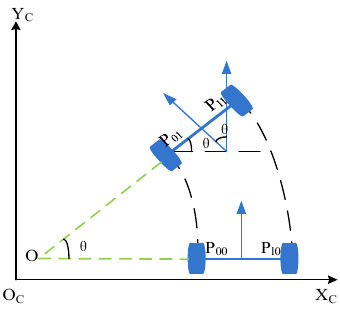
Figure 3. Target pose in a 2-dimension plane.